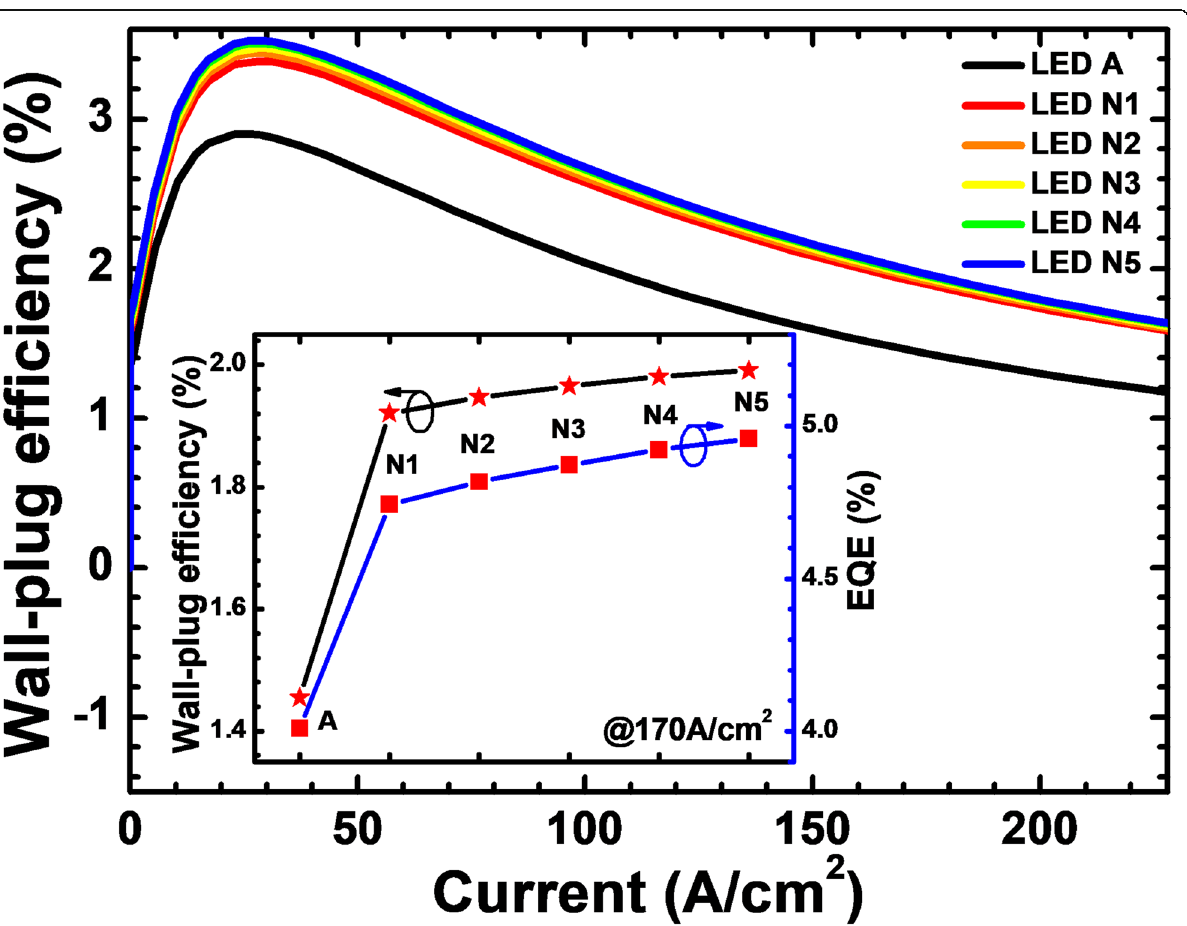
Fig. 17 Relationship between WPE and the injection current for LEDs A and N i ( i = 1, 2, 3, 4, and 5). Inset: the EQE and WPE for the investigated LEDs structured with various NPN-AlGaN number when the current density is 170 A/cm